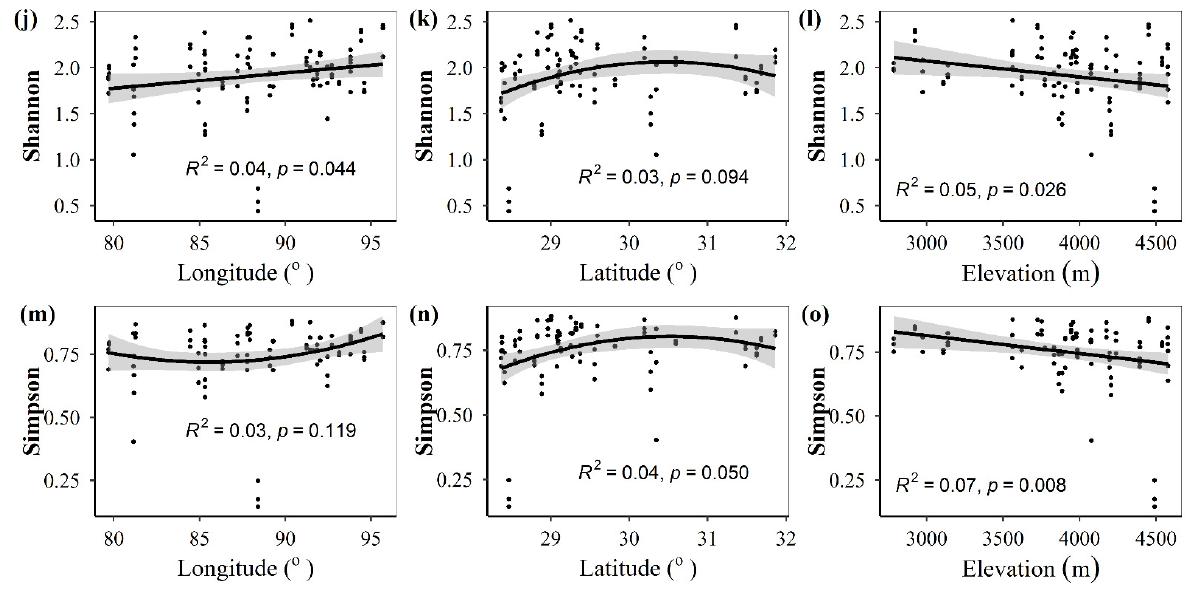
Figure A16. Relationships between functional α -diversity and geographic variables (longitude, latitude, and elevation) at 10–20 cm depth. ( a – c ) numbers of FunGuild at guild level (Guilds), ( d – f ) Chao1, ( g – i ) ACE, ( j – l ) Shannon, and ( m – o ) Simpson.